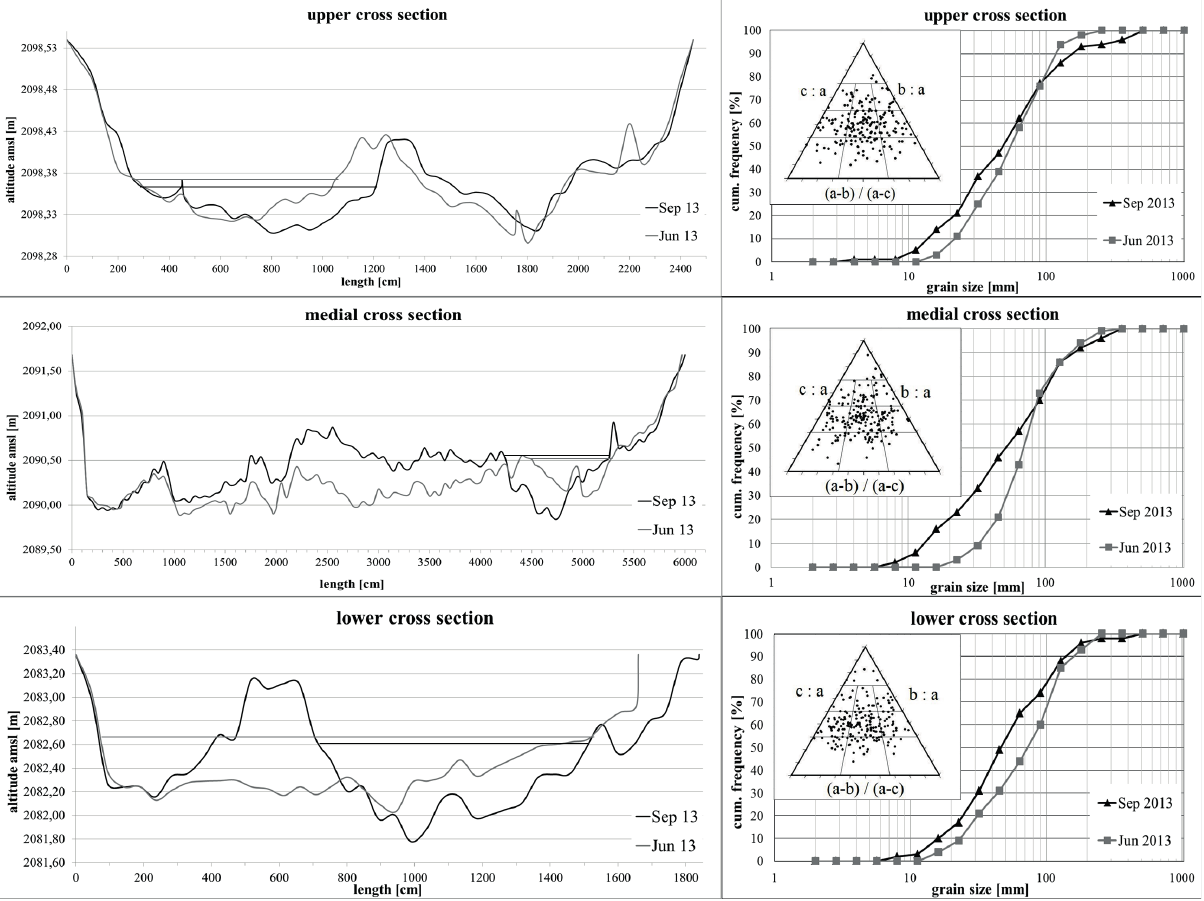
Fig. 5 Cross-section profiles and cumulative frequency distribution of particle count samples from June and September 2013. The stage during the cross-section surveys is presented as a grey line (June 2013) and black line (September